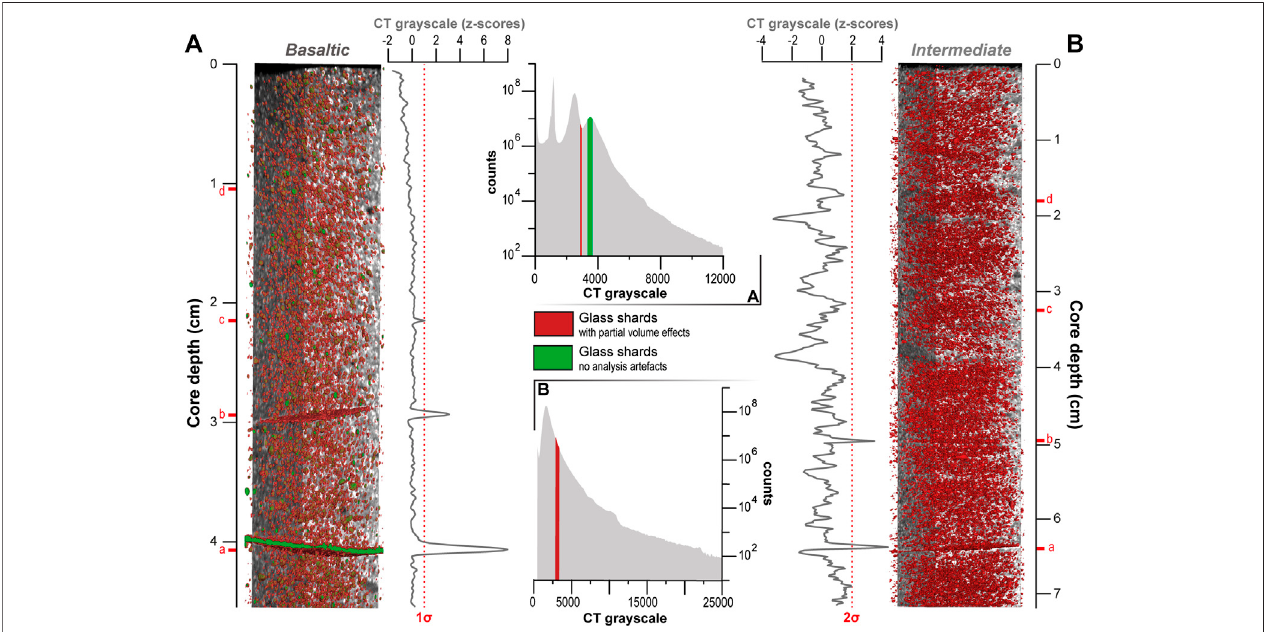
FIGURE 4 | Inter-connected 2-D CT orthoslices and 3-D representationsof horizons ofbasaltic (A) and intermediate (B) glass in the synthetic peat cores scanned forthisstudy.Thehistogramsshowthegrayscalevaluedistributionofeachscaningray,whilehighlightingtherangeofpartial-volumeaffectedglassinredandpureglass ingreen.Down-coreCTgrayscalevariabilityisplottedasstandardizedz-scorevalues,markingonetotwostandarddeviations( σ )withastippled redline.Thepositionof each arti fi cial (crypto) tephra horizon is highlighted with a red dash (and